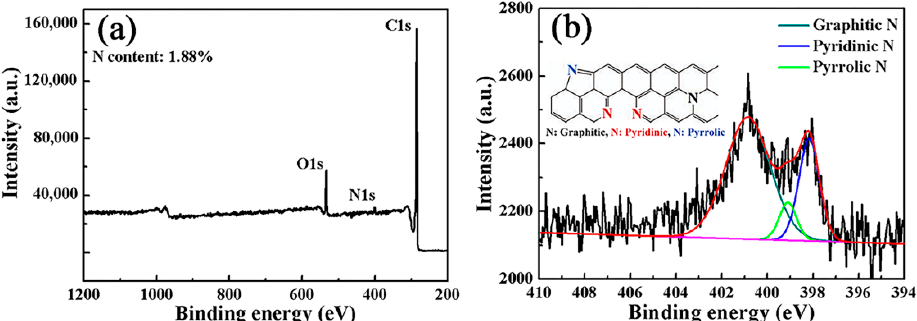
Figure 5. ( a ) X-ray photoelectron spectroscopy (XPS) wide range survey spectrum and ( b ) high- resolution XPS spectrum of N 1s for a sample of N CNFs-1 (the inset shows the various configurations of N atoms doped in graphene